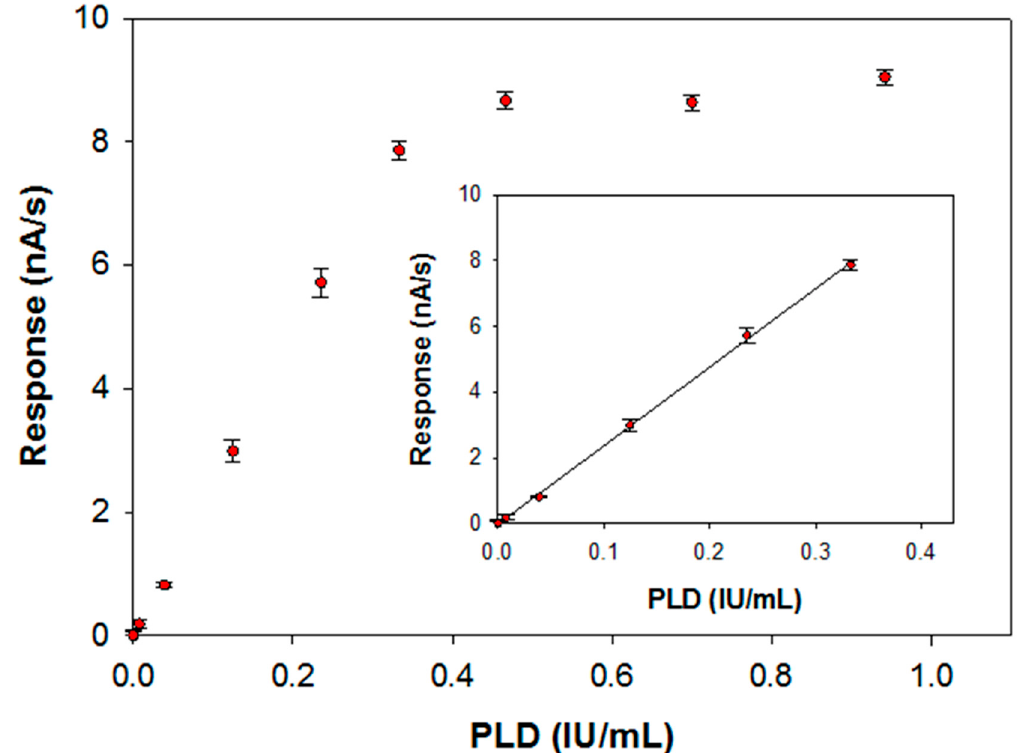
Figure 7. Calibration curve for phosphatidylcholine-PLD system carried out at a typical biosensor. Supporting electrolyte: borate bu ff er pH 8.0, I 0.05 M containing 0.75% (v / v) Triton X-100, Pt/PPyox/ChO biosensor. Supporting electrolyte: borate buffer pH 8.0, I 0.05 M containing 0.2 mM calcium chloride and 5 mM phosphatidylcholine. Electrode rotation rate: 200 rpm. Inset: linear 0.75% (v/v) Triton X-100, 0.2 mM calcium chloride and 5 mM phosphatidylcholine. interval of the calibration Electrode rotation rate: 200 rpm. Inset: linear interval of the calibration curve.